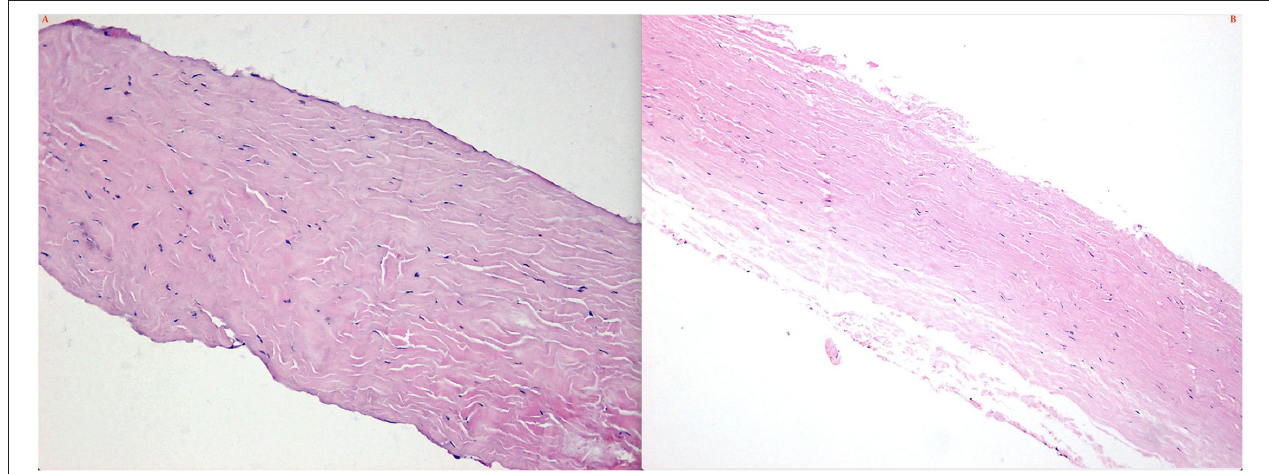
FIGURE 12 | Histochemical features of the scleras in type 1 (A) and type 2 (B) . Note the collagen fibers bundles was variable diameters, arranged irregularly; spaces between collagen fibers bundles were enlarged.